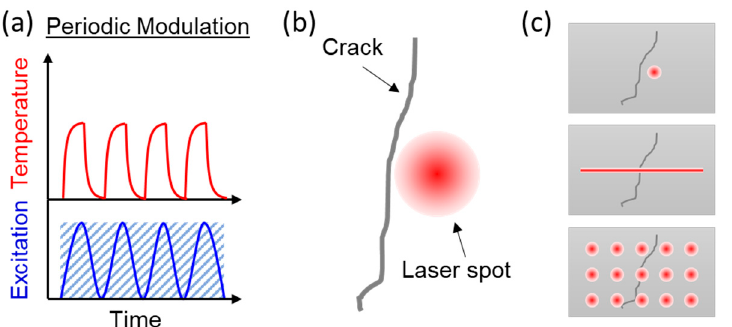
Figure 1. ( a ) Time domain optical excitation and surface temperature profile at the excitation point under periodic modulation. ( b ) The schematic of an open crack with a laser spot in its vicinity. The diameter of the laser spot is chosen to confine 1/e 2 of the intensity. ( c ) Surface crack detection schemes using a single spot, a single line, and multi-spots by a predesigned di ff ractive optical ele- ment.